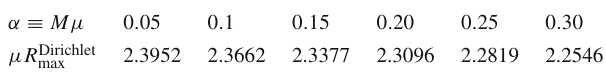
Table 1 Composed charged-reflecting-star-charged-massive-scalar- field configurations. We present, for various values of the dimension- less physical parameter α ≡ M μ , the largest possible dimensionless radii μ R Dirichlet max (α) of the spherically symmetric charged reflecting stars that can support the static spatially regular configurations of the charged massive scalar fields. One finds that the maximally allowed radii μ R Dirichlet max (α) of the central supporting stars are a monotoni- callydecreasingfunctionofthestar-fielddimensionlessmassparameter α ≡ M μ . The data presented is for the case β = 5 [see Eq. (15)]. Note that the assumption R s (cid:2) M [see (9)] is valid for α (cid:2) 0 . 25